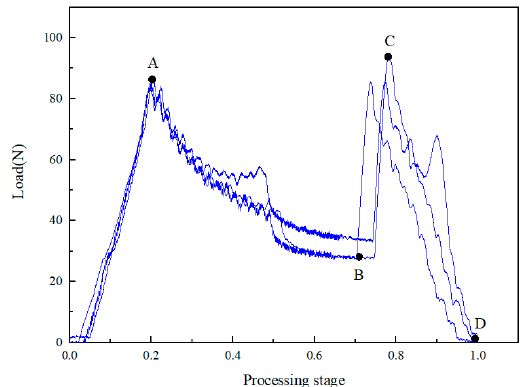
Figure 5. Axial force time curve of composites at dynamic rotation speed 4000 – 2000 r/min.